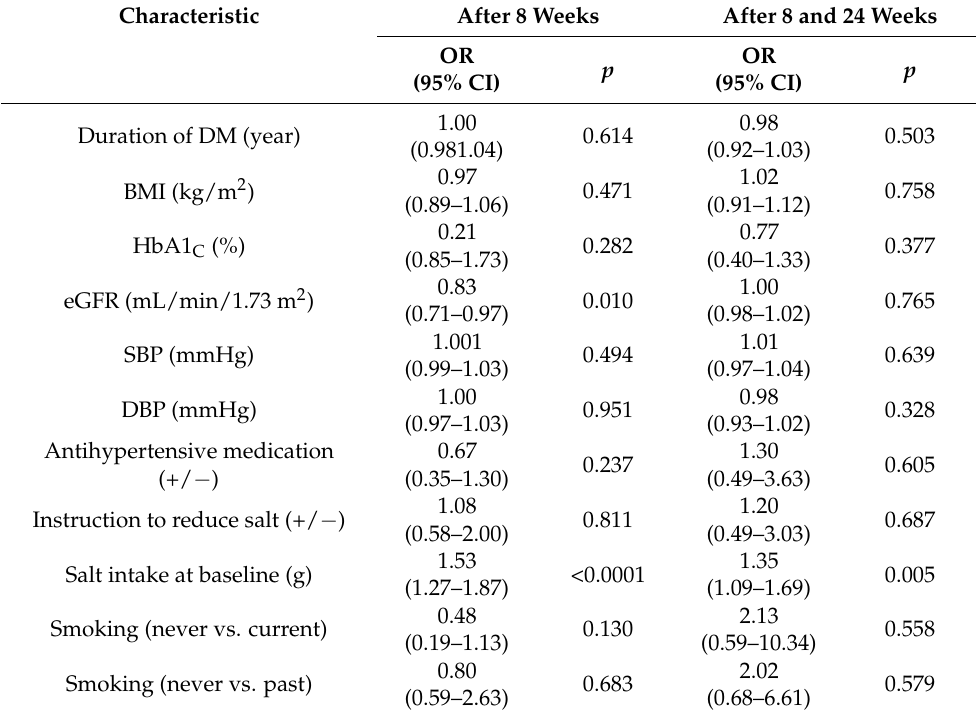
Table 2. Odds ratios of factors associated with salt intake reduction after 8 weeks, or after 8 weeks and 24